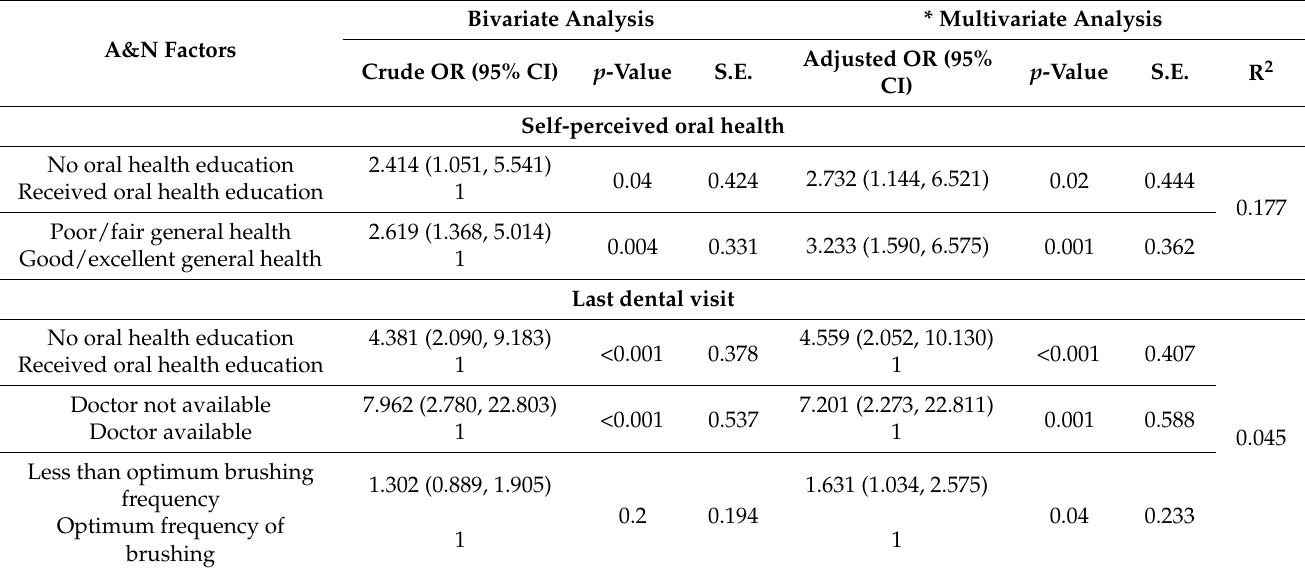
Table 5. Multivariate logistic regression depicting predictors from Andersen and Newman